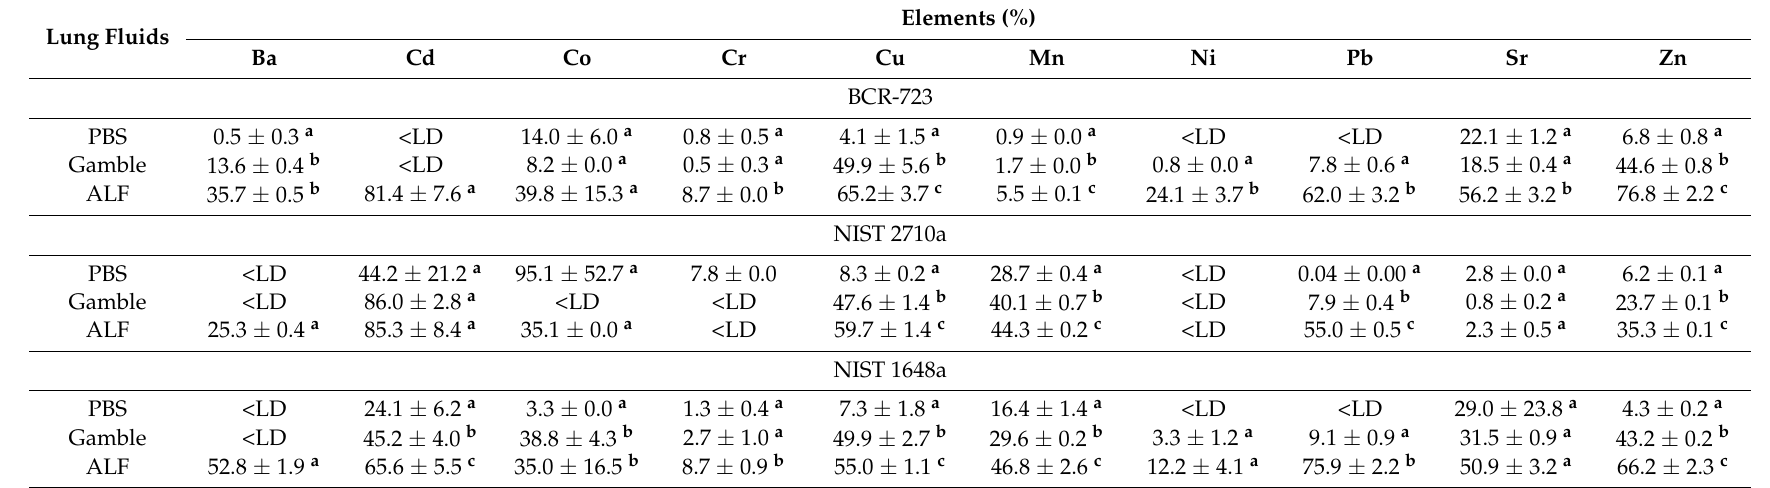
Table 3. Bioaccessibility values (%; mean ± SD; n = 3) of metallic elements in the three reference materials for a S/L ratio of 1/5000 in the three lung fluids (PBS, Gamble’s solution and